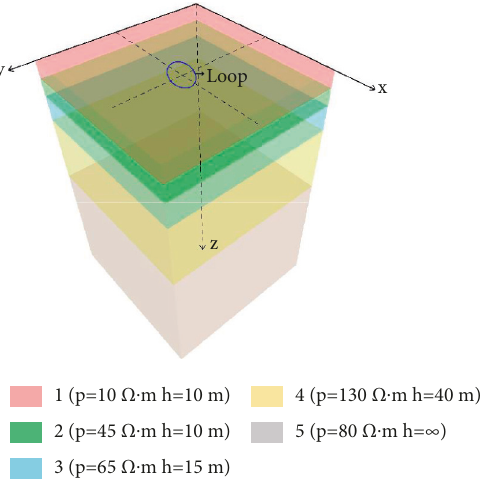
Figure 3: Forward modeling of TEM. Table 1: Test model parameters.